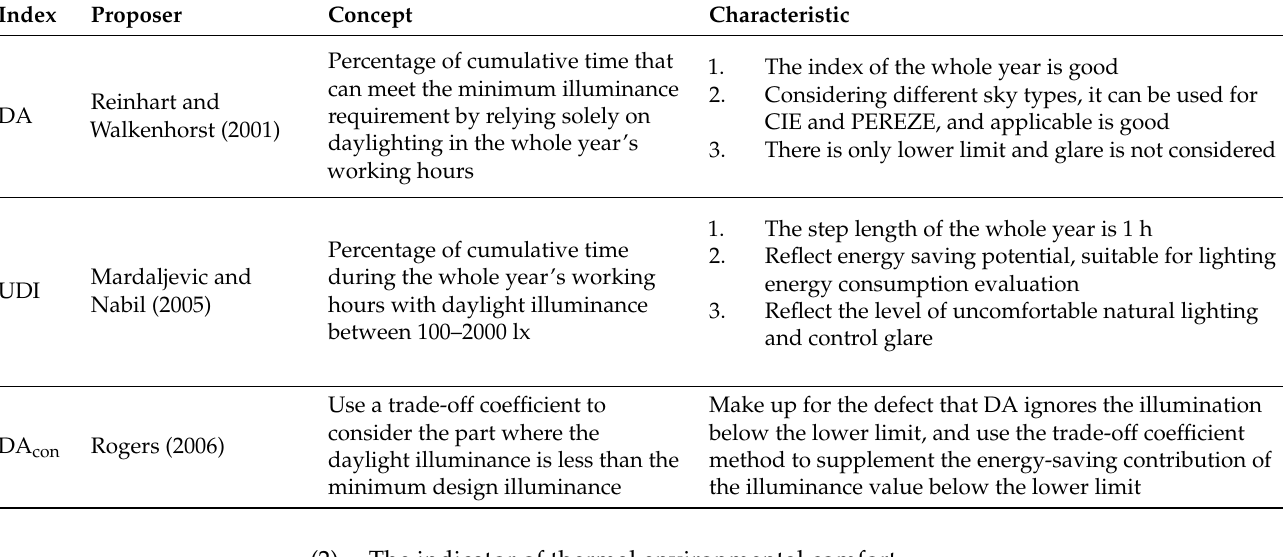
Table 2. Dynamic lighting environment evaluation